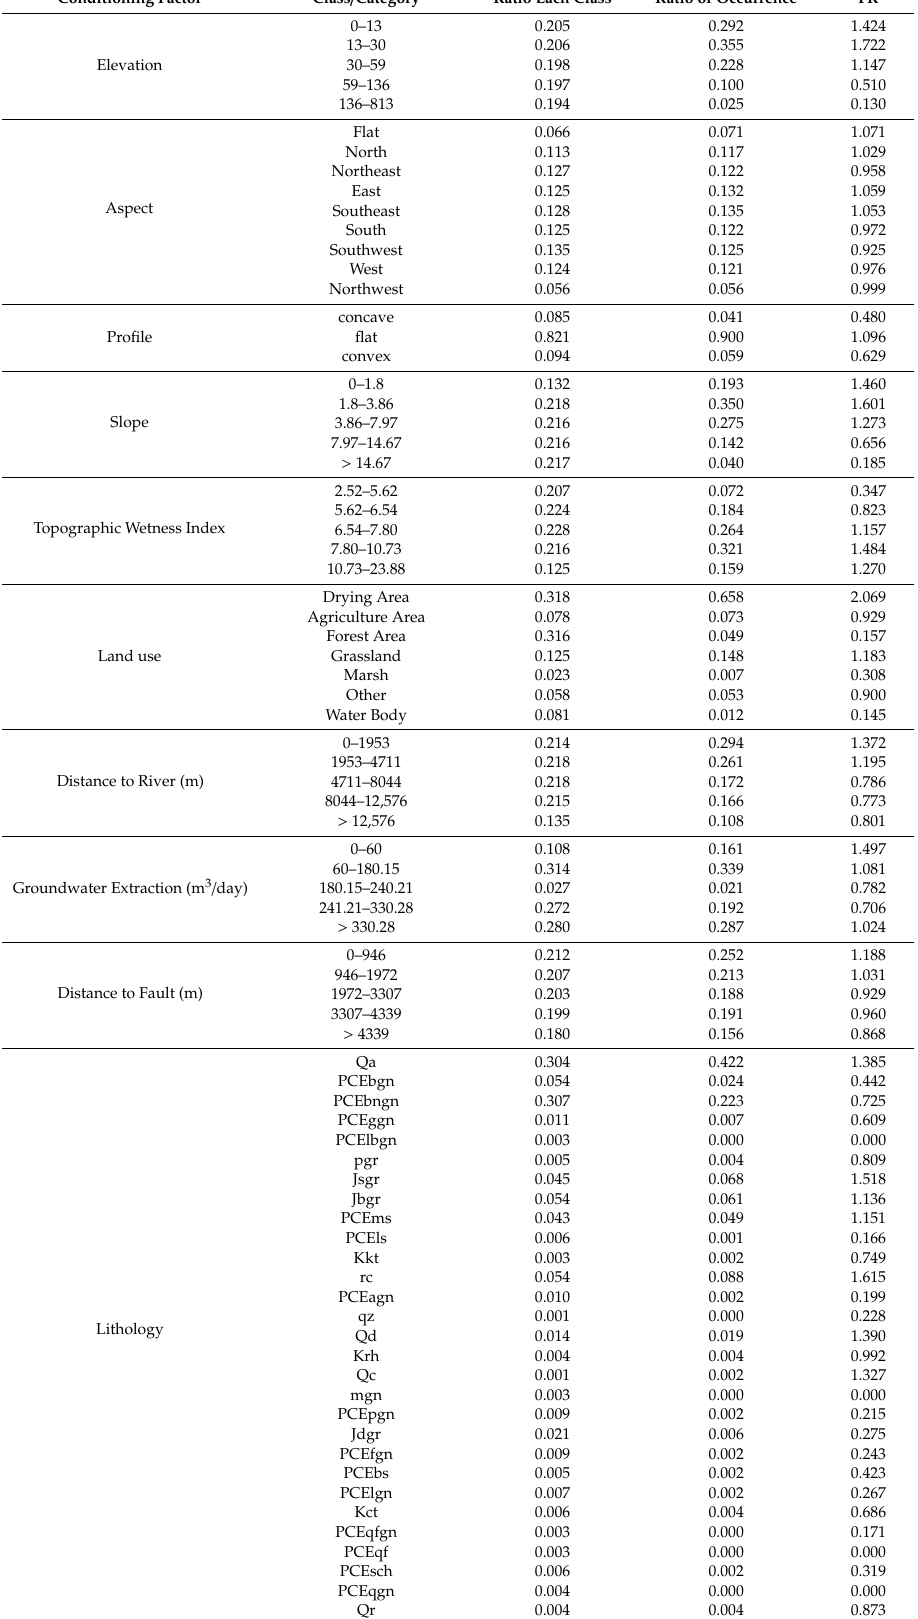
Table 3. Frequency Ratio